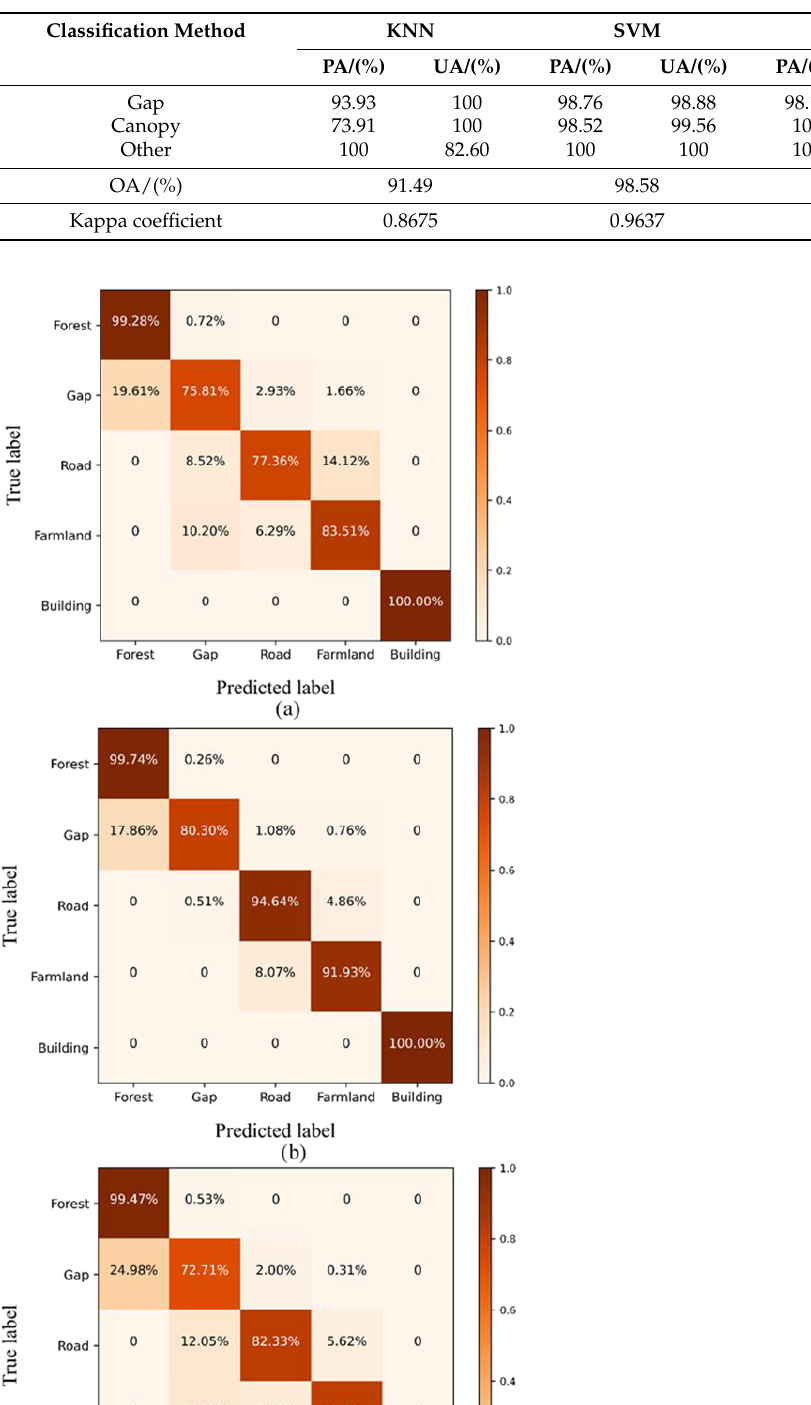
Table 3. The classification accuracies using edge information of study area I. Including the producer’s